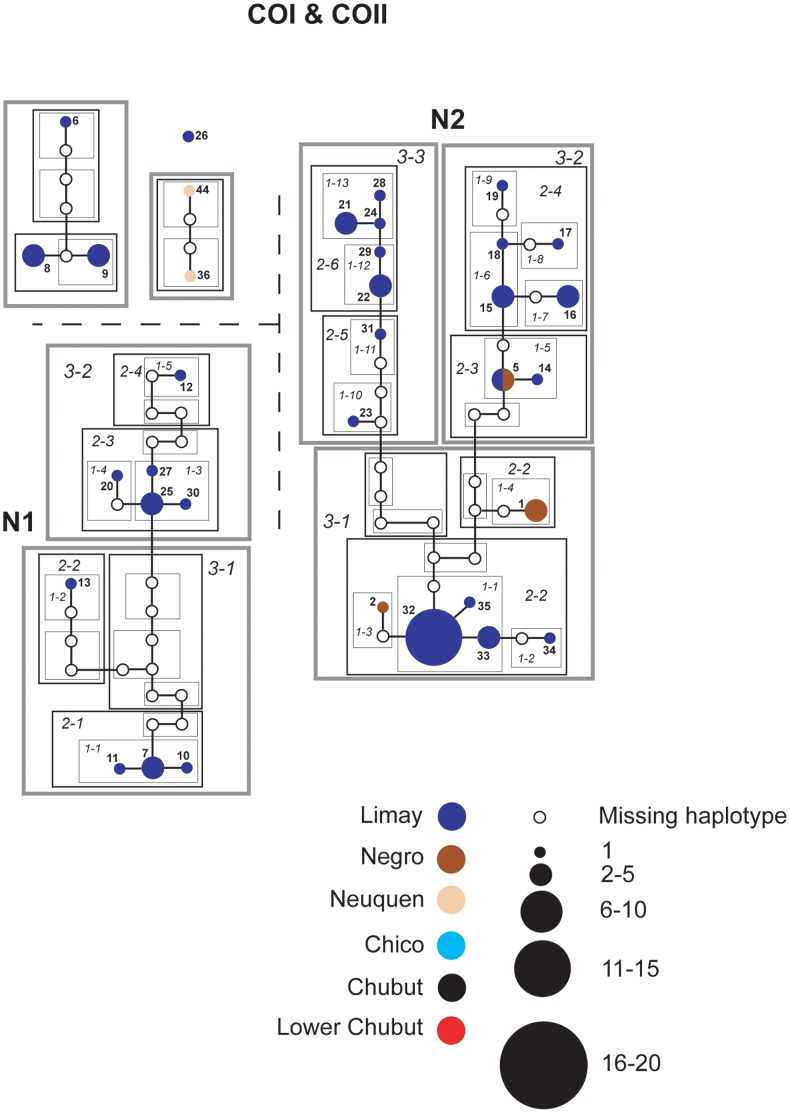
Haplotype networks with nested clade design for mtDNA (COI & COII) sequence data of Limay, Negro and Neuquen Rivers.Haplotype circle size is proportional to its frequency. Each haplotypes is numbered. Haplotypes that exceed twenty individuals are labeled with the total number of individuals of that haplotype. Arrow indicates the root haplotype. Black empty circles represent extinct (or unsampled) haplotypes. Color codes indicate the six major rivers.